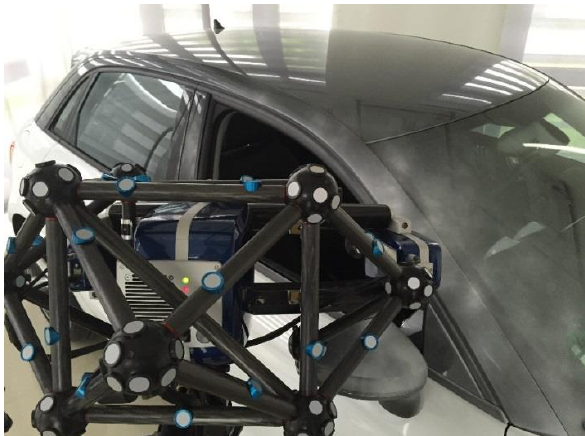
Figure 16: Scanner with target